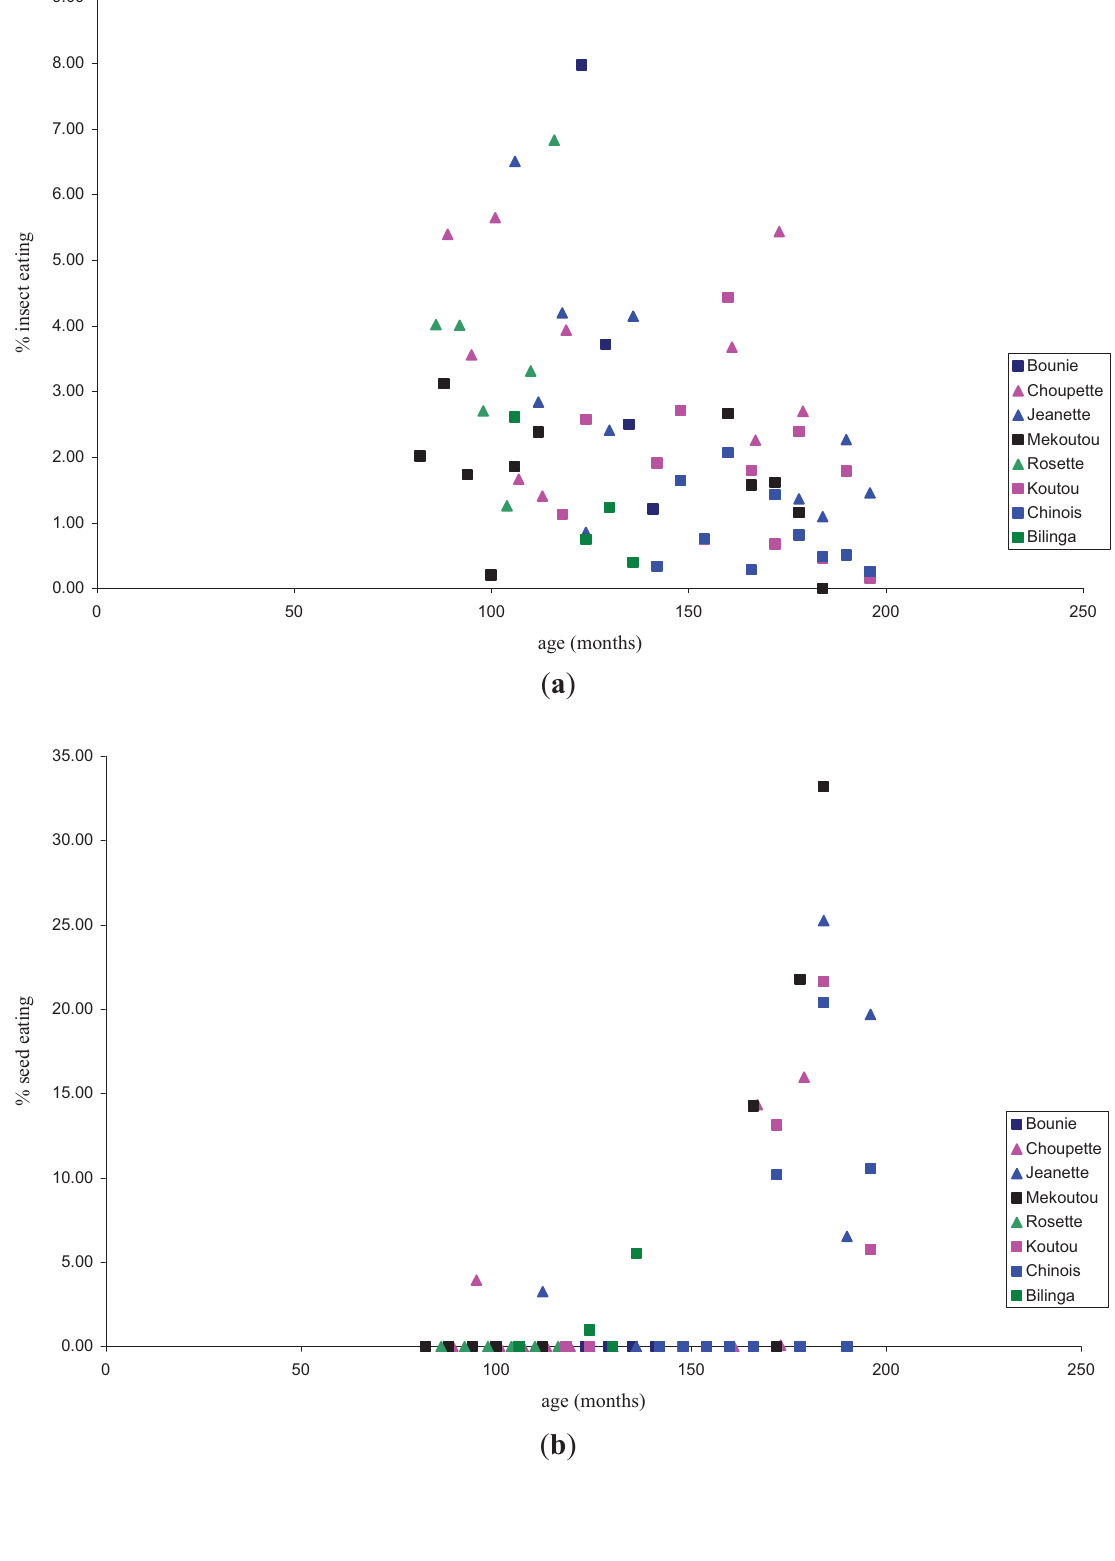
Figure 3. Significant relationships with age and ( a ) % insect eating; ( b ) % seed eating; ( c ) % time grooming. Each individual is represented as a separate symbol. Females are shown as triangles and males as